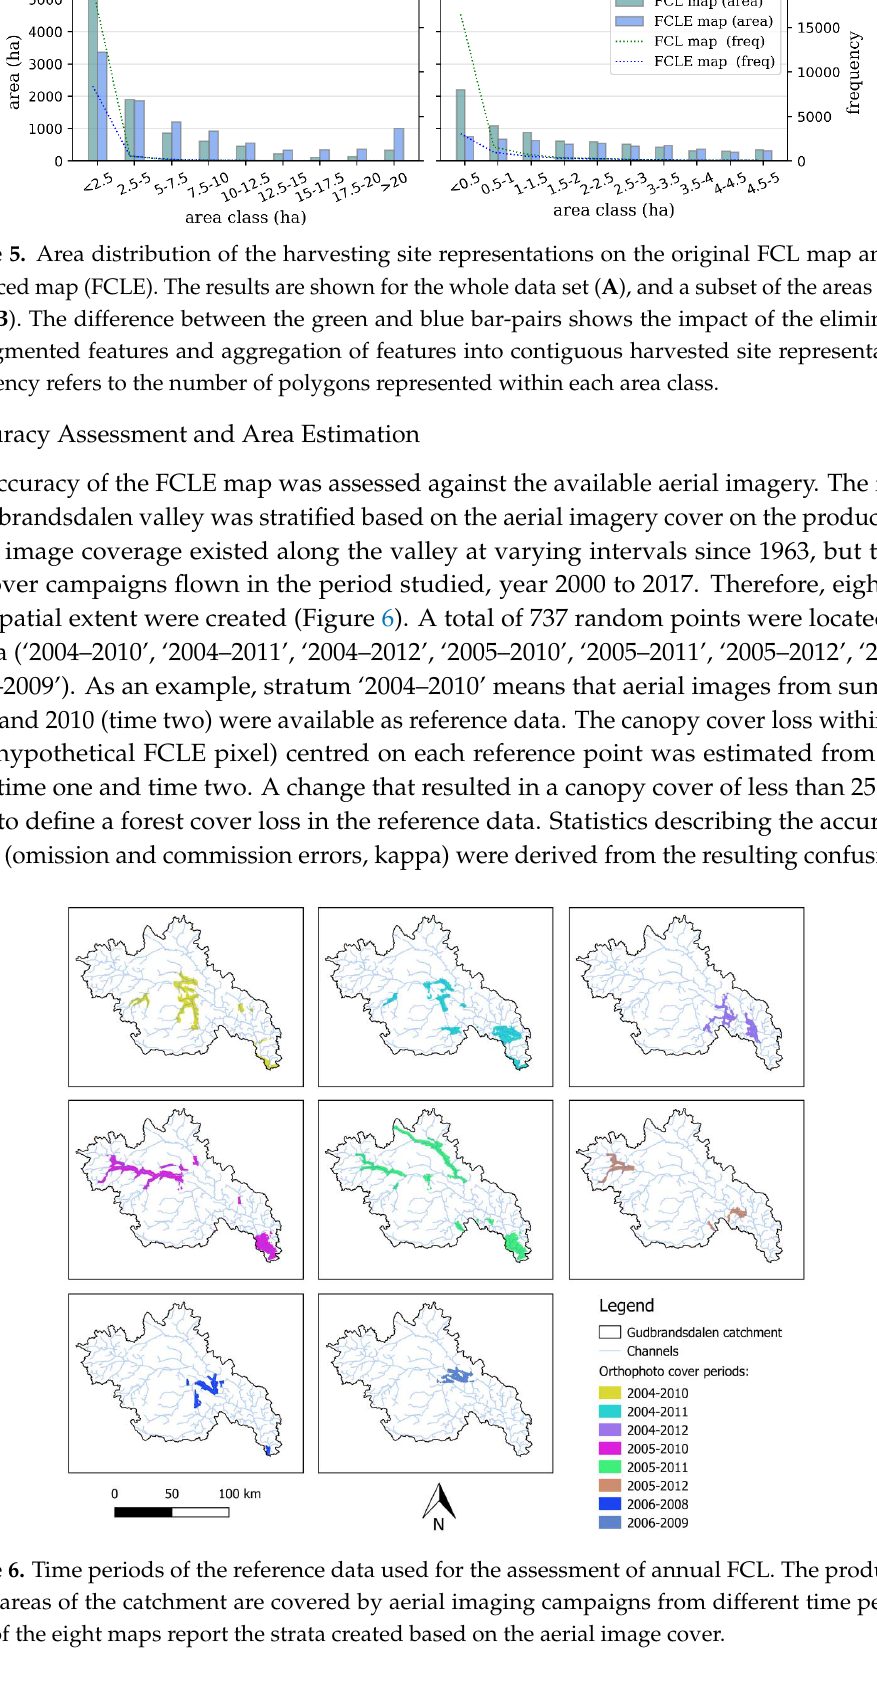
Figure 7. Area distribution and frequency of occurrence of the manually delineated harvested sites to area classes (ha).